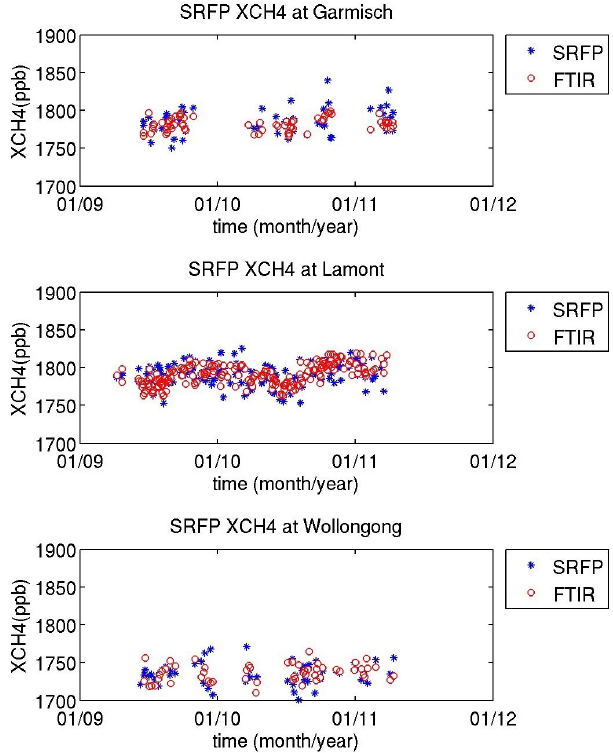
Figure 16. Daily averaged time series of paired SRFP and TC- CON FTIR XCH 4 at Garmisch (top), Lamont (mid) and Wollon- gong